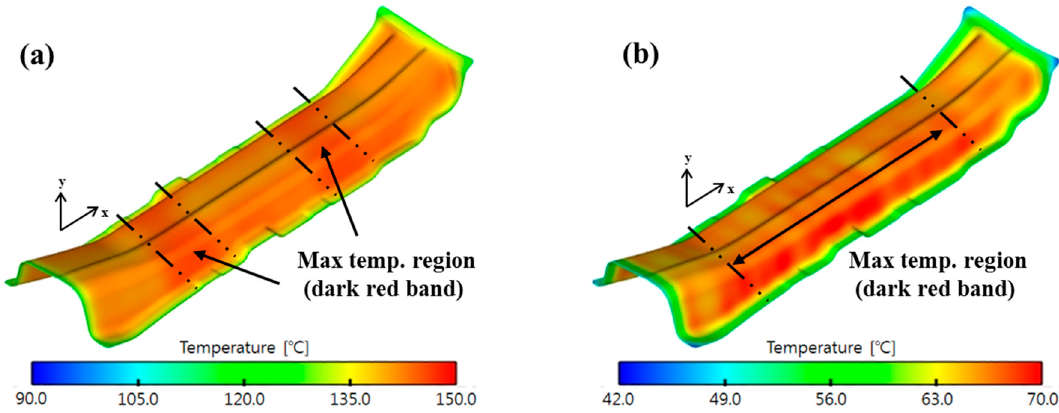
Figure 9. Temperature distribution at holding time 12 s ( a ) Conventional die; ( b ) Slice die.